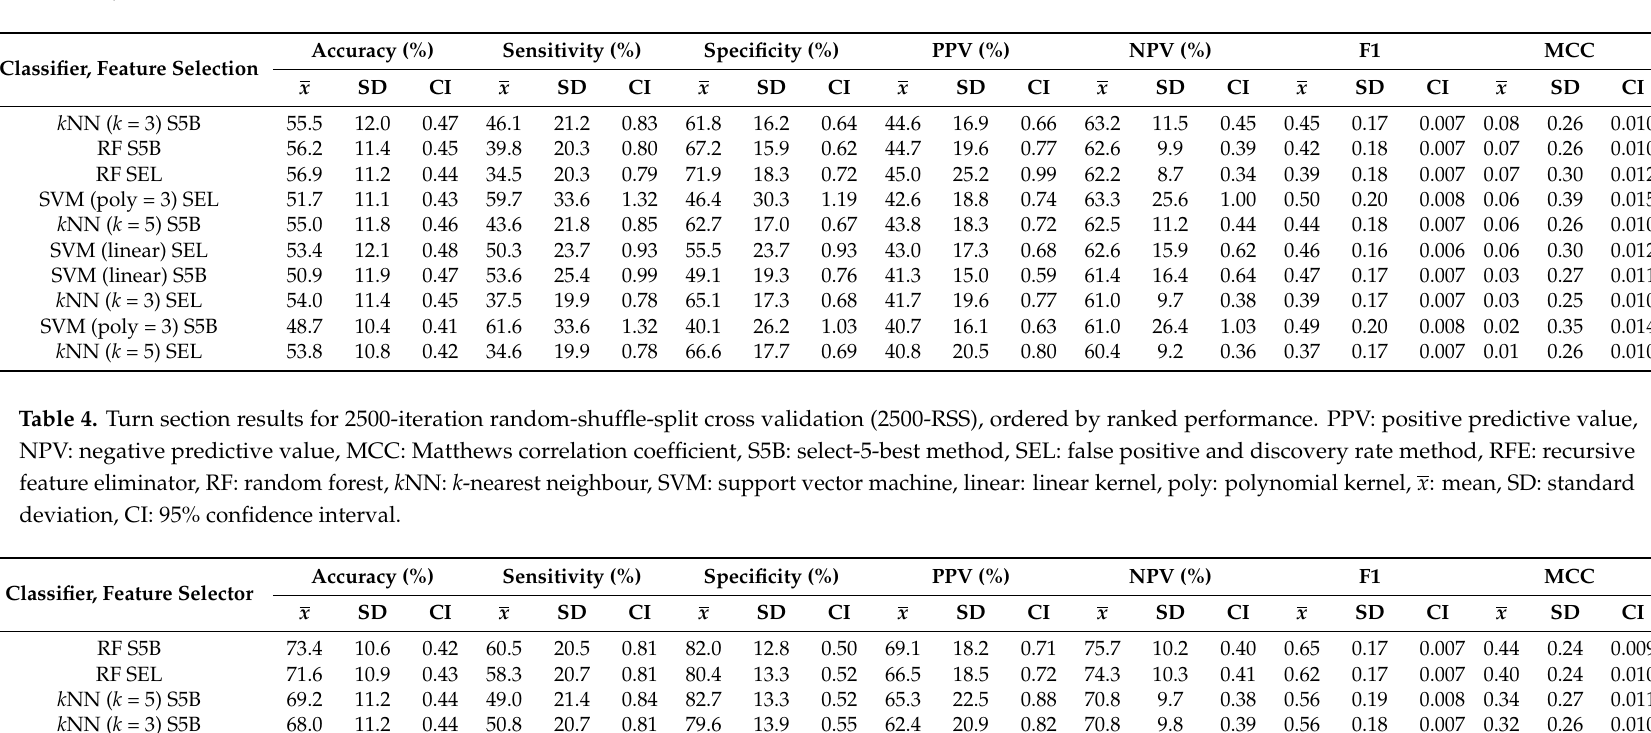
Table 3. Straight-walking section results for 2500-iteration random-shuffle-split cross validation (2500-RSS), ordered by ranked performance. PPV: positive predictive value, NPV: negative predictive value, MCC: Matthews correlation coefficient, S5B: select-5-best method, SEL: false positive and discovery rate method, RFE: recursive feature eliminator, RF: random forest, k NN: k -nearest neighbour, SVM: support vector machine, linear: linear kernel, poly: polynomial kernel, x : mean, SD: standard deviation, CI: 95% confidence interval.